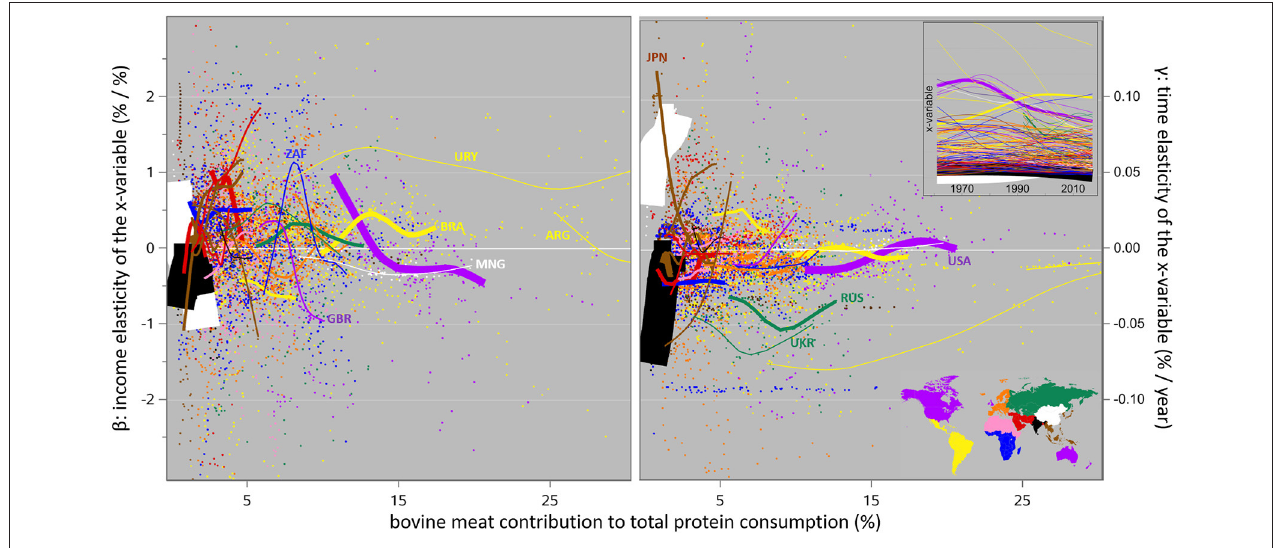
FIGURE 9 | The same relations as in Figure 8 , for bovine meat.